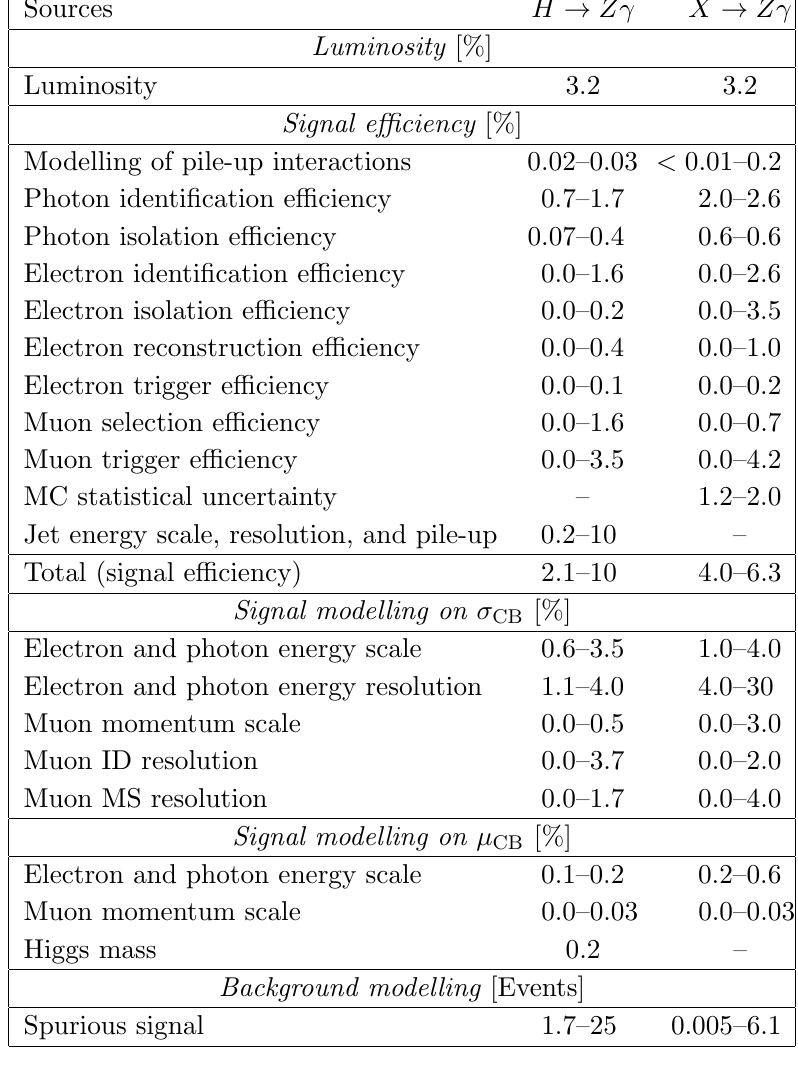
Table 4 . The main sources of experimental uncertainty for the H=X ! Z(cid:13) searches. The gluon- gluon fusion signal samples produced at m H = 125 GeV and m X = [300{2500] GeV are used to estimate the systematic uncertainty. The ranges for the uncertainties span the variations among di(cid:11)erent categories and di(cid:11)erent m X resonance masses. The uncertainty values are given as fractions of the total predictions, except for the spurious signal uncertainty, which is reported as the absolute number of events. Values are not listed if systematic sources are negligible or not